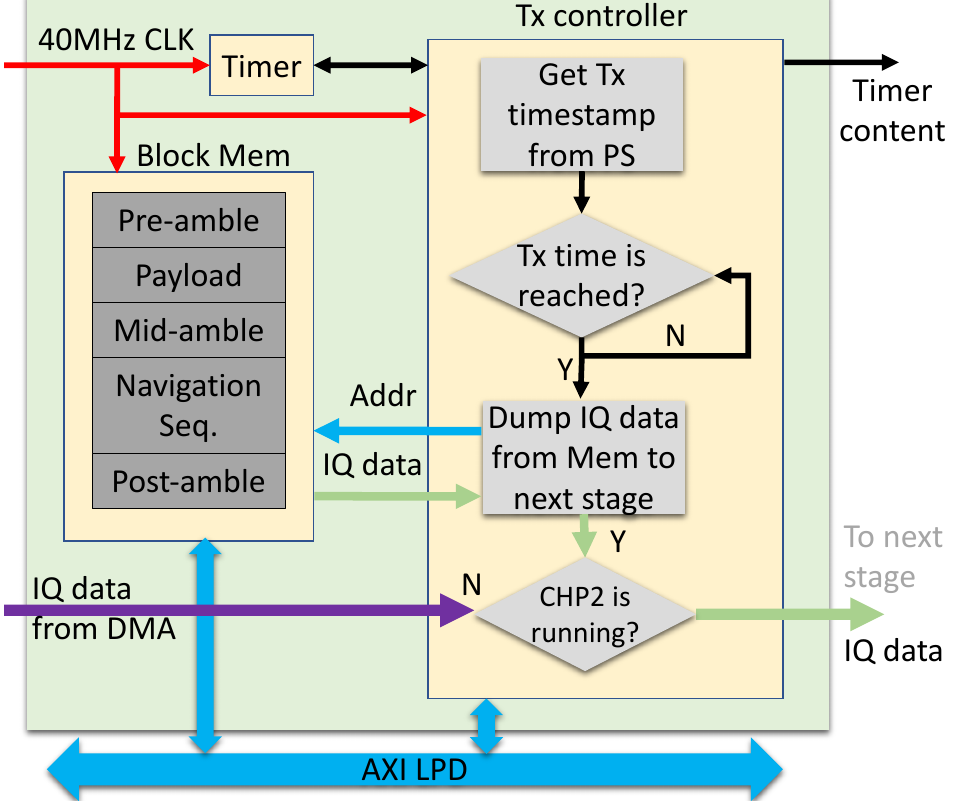
Figure 15. Transmit engine block diagram.